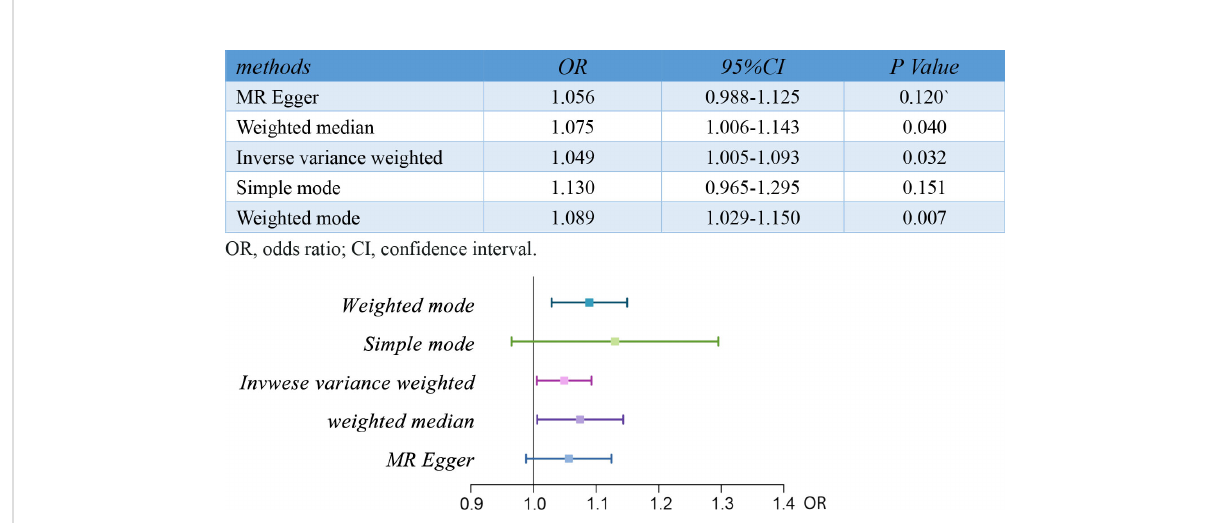
FIGURE 2 Results of MR analyses conducted to estimate potential associations between RA and risk of pre-eclampsia. MR, mendelian randomization; RA, rheumatoid